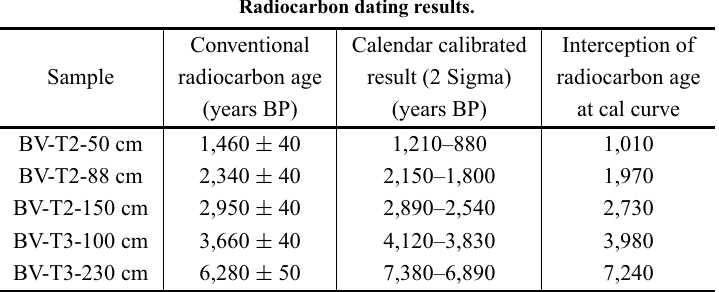
Radiocarbon dating